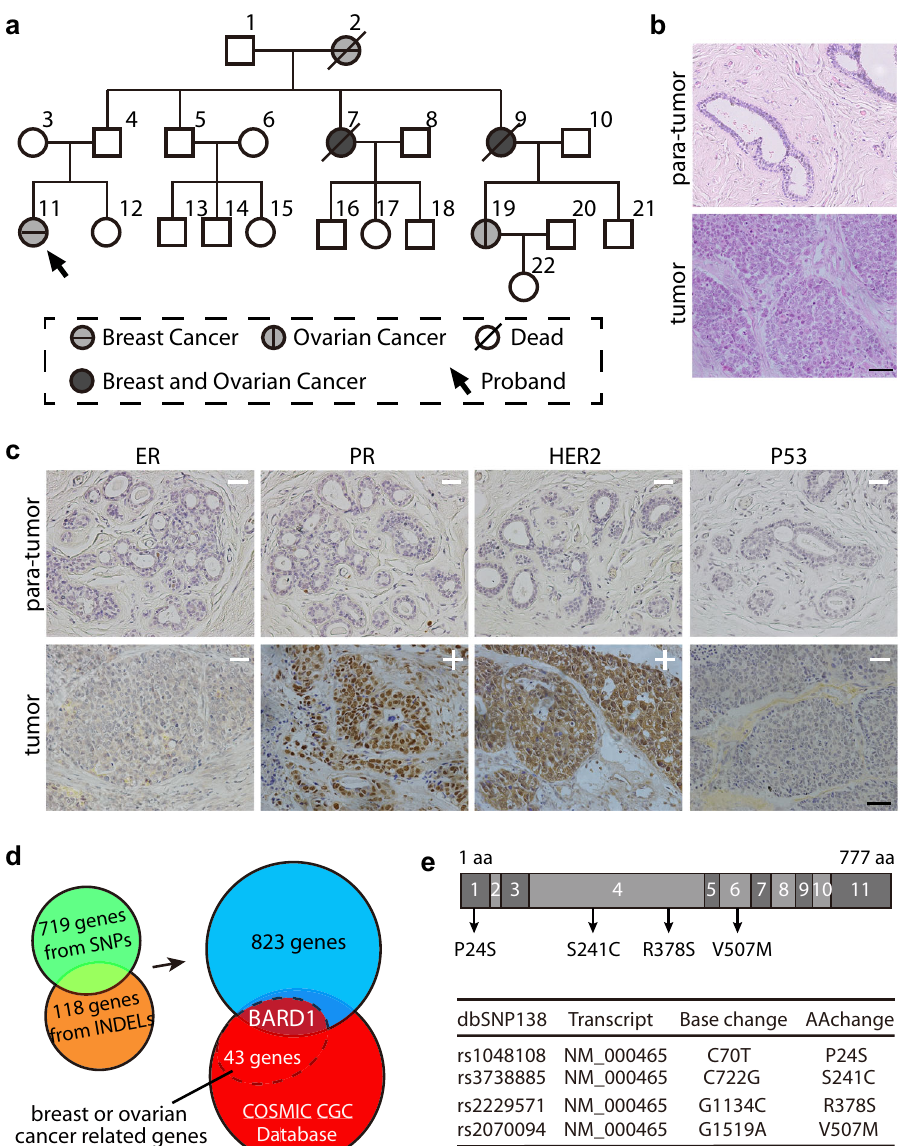
Fig. 1 Mutational analysis of a hereditary breast and ovarian cancer (HBOC) family. a Pedigree of the HBOC family. Circles indicate females and squares indicate males. The black arrow indicates the proband. Genomic DNA samples of the proband (#11) and all surviving female siblings (#12, 15, 17, 19) (except #22, a 9-year-old girl) were analyzed with Whole Genome Sequencing. b H&E staining of proband mammary tissues. Mammary tissues from proband para-tumor and tumor mass were harvested and H&E stained. Scale bar, 50 μ m. c Pathological marker staining of proband mammary tissues. Mammary tissues from proband para-tumor and tumor mass were harvested and stained for ER, PR, HER2, and P53. Signal positive and negative are denoted by ‘ + ’ and ‘ − ’ , respectively. Scale bar, 50 μ m. d Gene screening fl owchart by bioinformatics analysis. Different clusters were generated from the WGS data via multiple bioinformatic approaches (SIFT, PolyPhen2, PROVEAN, etc) combined with public database (COSMIC CGC database) searching. Only the BARD1 gene was fi ltered out as a candidate pathogenic gene highly related to both breast and ovarian cancer. e BARD1 mutations in the HBOC family. The BARD1 mutations are annotated across the coding sequence of the gene ’ s 11 exons. The SNP IDs and corresponding amino-acid changes in BARD1 are